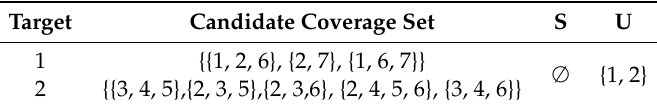
Figure 7. The initial state of WSNs. No sensors are activated, and no targets are covered. Table 2. F [ 1 ] = 1, F [ 2 ] = 2, F [ 3 ] = 1, F [ 4 ] = 1, F [ 5 ] = 1, F [ 6 ] = 2, F [ 7 ] =